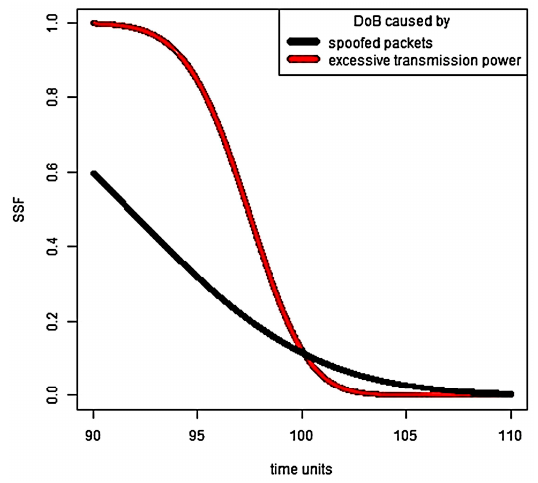
Figure 7. System survivability and varied types of DoB.